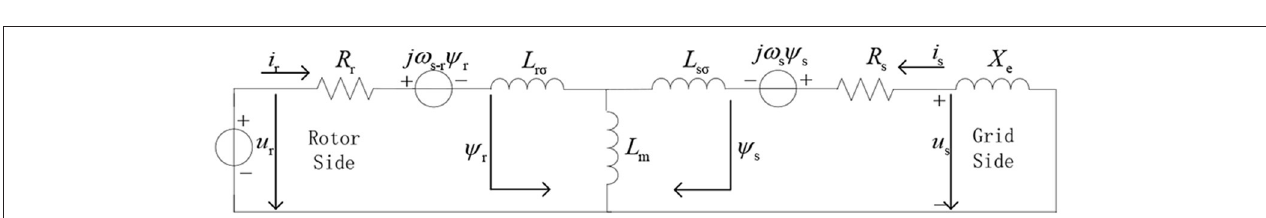
FIGURE 2 | Equivalent circuit of a DFIG after the fault.